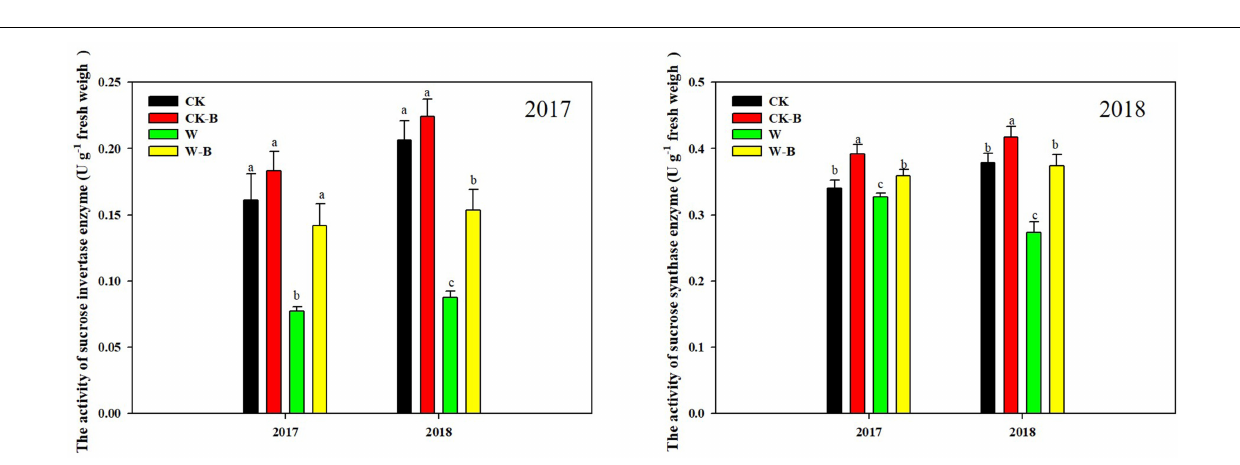
FIGURE 5 | The effects of 6-BA on the activities of sucrose-cleaving enzymes at T1 stage. CK, control, no waterlogging stress; CK-B, spraying 6-BA on non-waterlogged plants; W, waterlogging; W-B, spraying 6-BA after waterlogging. Different letters on bars indicate the significant differences among treatments at P < 0.05 using the LSD